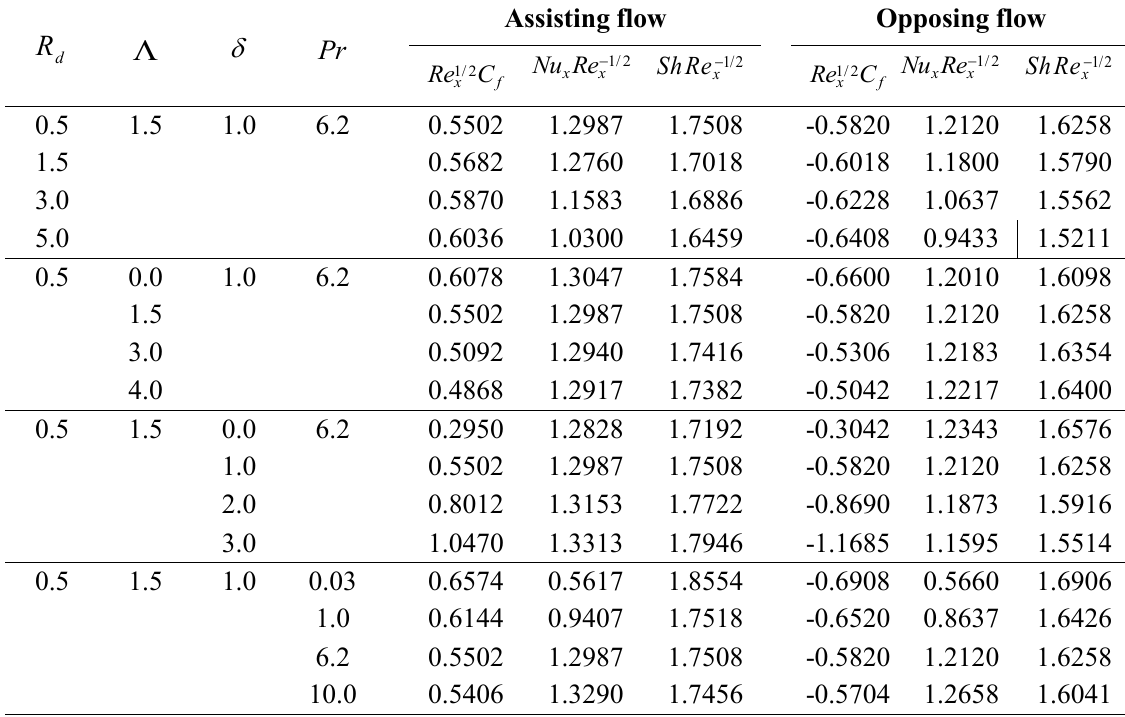
The effect of d R , Λ , δ and Pr on the skin friction coefficient, local Nusselt number, local Sherwood number for both cases of assisting and opposing flows , when